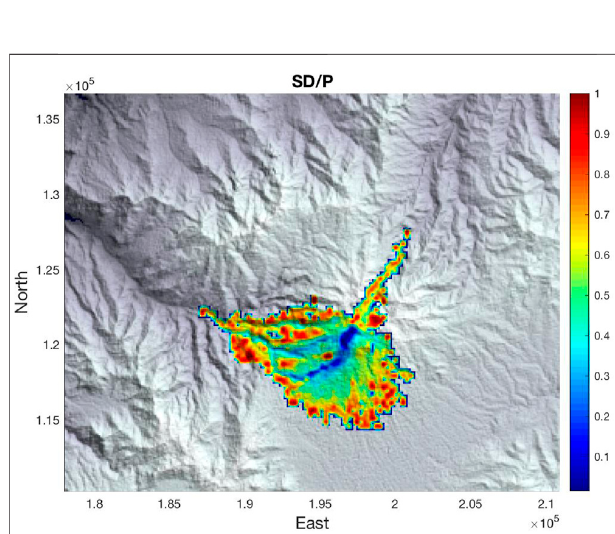
FIGURE 9 | Titan2D emulator based probability of exceeding 0.2 m fl ows in Scenario 2. Note similarity of probability of noticeable fl ow extent to mapped extent of Carrizo and Calera fl ows.